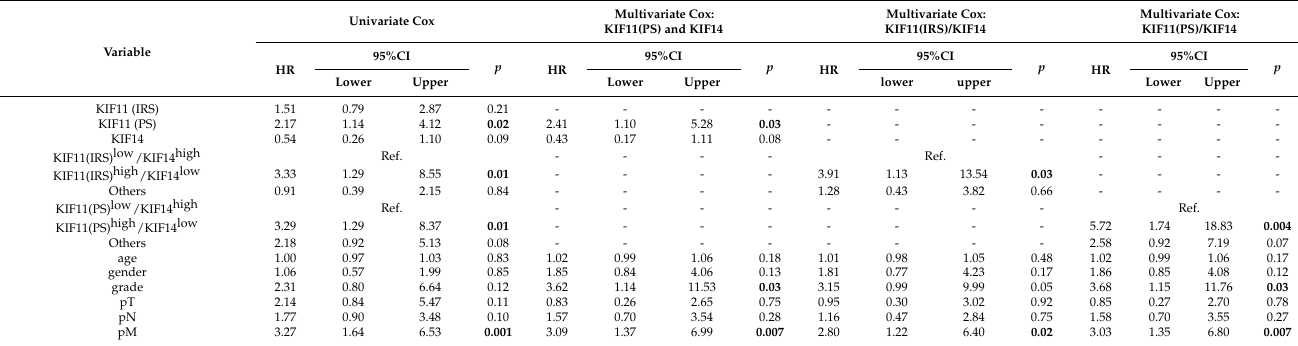
Table 2. Univariate and multivariate Cox proportional hazards models for OS of our cohort of CRC patients. UnivariateCox MultivariateCox: KIF11(PS)andKIF14 MultivariateCox: KIF11(IRS)/KIF14 MultivariateCox: KIF11(PS)/KIF14 Variable HR